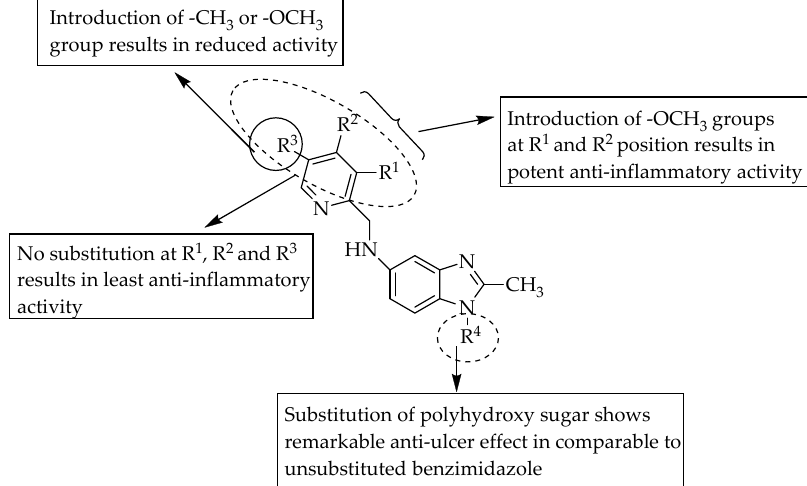
Figure 44. SARs of 5-aminopyridinyl substituted benzimidazoles. Earlier in 2002, Sodhi et al. studied the anti-inflammatory activity of tetrahydropy- rimido[1,6-a]benzimidazol-1(2 H )-thione derivatives with 50 mg/kg p.o. in the model of carrageenan-induced inflammation/oedema in rat hind paws. One of the reported com- pounds, 3-methyl-8-nitro-3,4,4a,5-tetrahydropyrimido[1,6-a]benzimidazol-1(2 H )–thione, showed comparable anti-inflammatory activity (46.0, maximum % reduction in oedema) to ibuprofen (51.0, maximum % reduction in oedema). Electron-rich groups at R 1 and R 2 , and an electron-withdrawing group at R 2 were unfavourable for anti-inflammatory activity, whereas an –NO 2 group at R 1 resulted in moderate anti-inflammatory activity (Figure 45) [68].